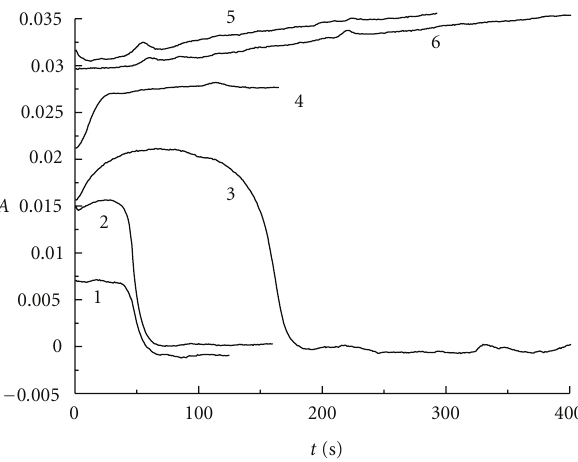
Figure 5: The absorbance versus reaction time at 460 nm for iodine: curve 1: r = 2 . 03; curve 2: r = 3 . 00; curve 3: r = 3 . 95; curve 4: r = 4 . 85.